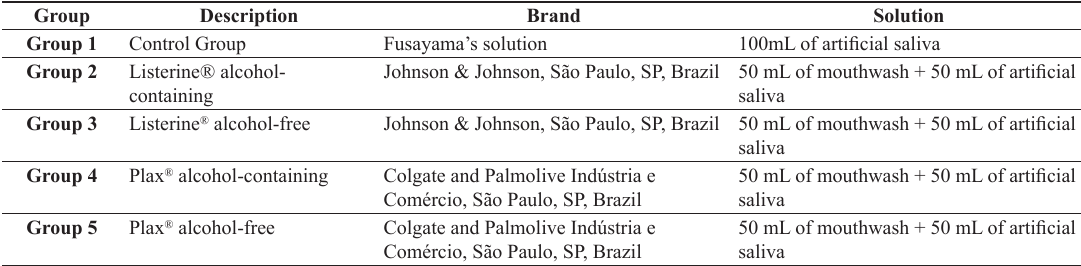
Table 1. Different mouthwashes used for each test